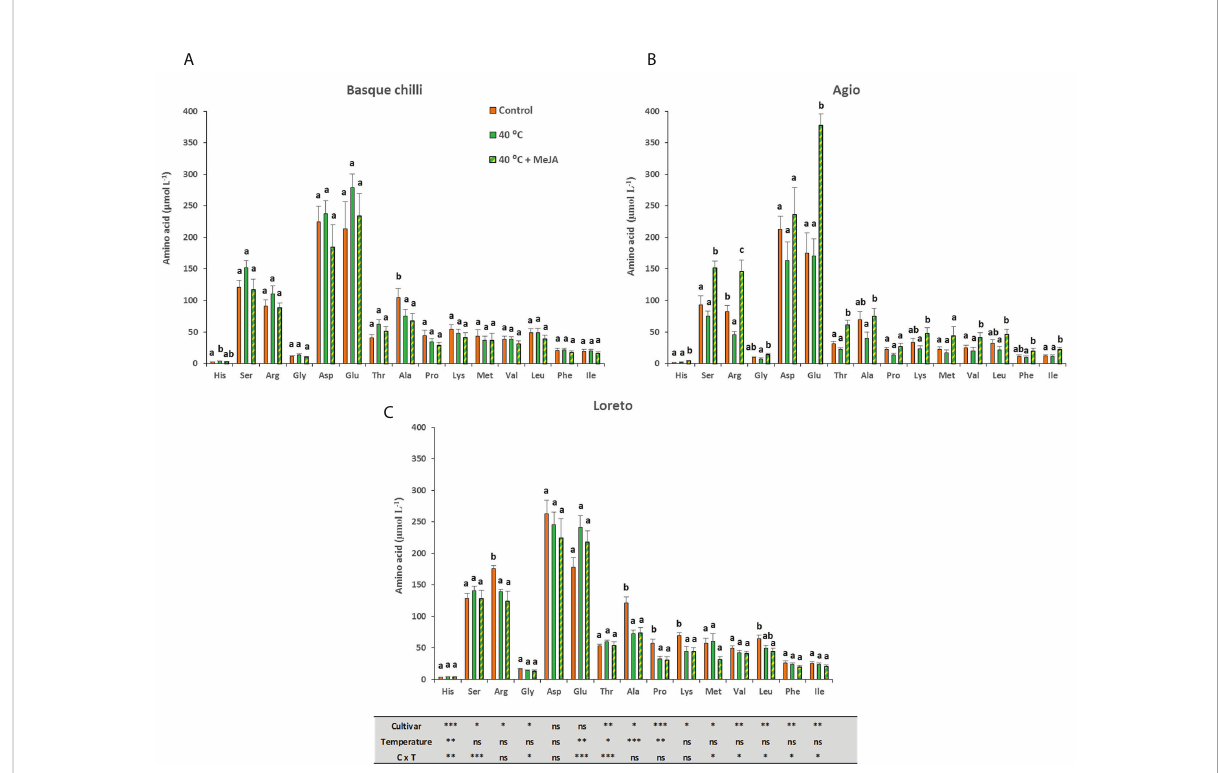
FIGURE 5 Effects of heat shock and MeJA on leaf amino acids concentration (µmol L -1 ) of the three pepper cultivars [ (A) Basque chilli, (B) Agio and (C) Loreto]. Values are means ± SE. Different letters indicate signi fi cant differences between treatments according to Duncan ’ s test at the 95% con fi dence level. The * refers to signi fi cant differences at the level of p ≤ 0.05; **p ≤ 0.005; ***p ≤ 0.001; n.s., not signi fi cant.